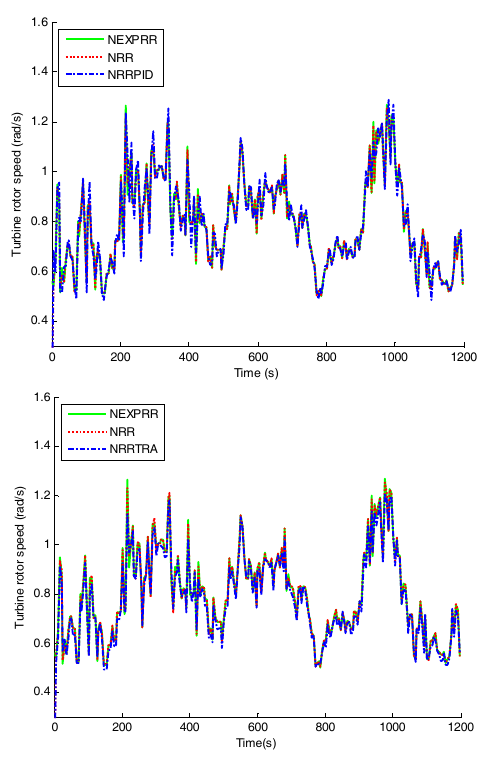
Figure 6. The turbine rotor speed.